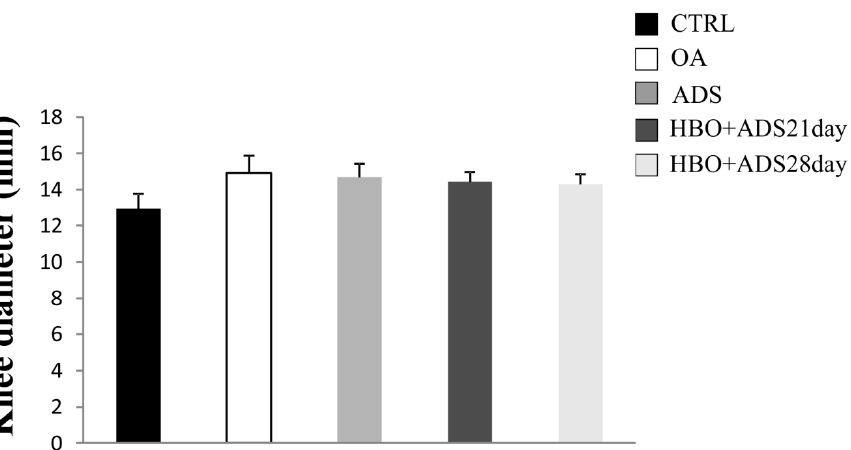
Figure 1. Changes in knee diameter in CTRL, OA, ADS, HBO+ADS 21day and HBO+ADS 28day groups. Values are presented as means ± mean standard error (SE).